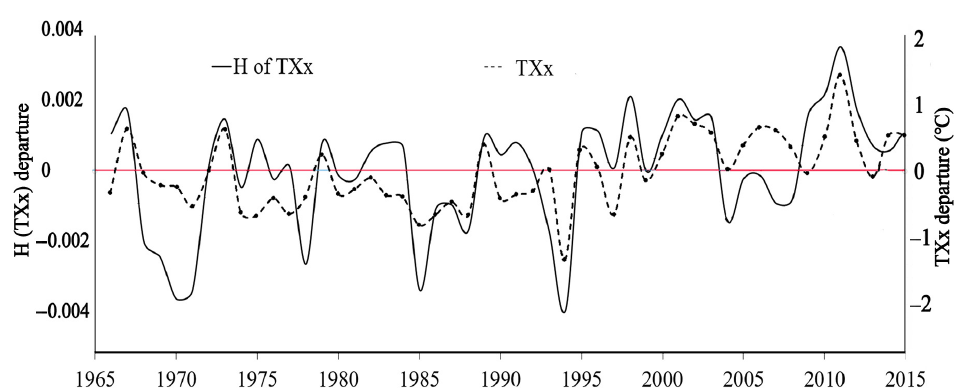
Figure 13. Temporal changes in H(TXx) and TXx departures in China, 1966 to 2015.